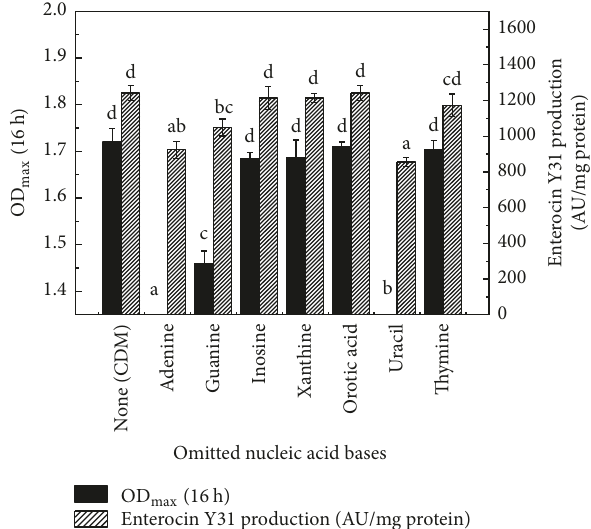
Figure 5: Effect of individually omitting each a nucleic acid base on the growth of Enterococcus faecium Y31 and Enterocin Y31 production. Means not sharing a common superscript letter are significantly different from each other ( 𝑃 < 0.05